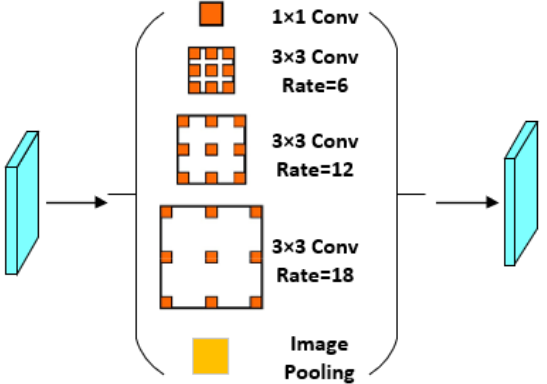
Figure 3. Illustration of Atrous Spatial Pyramid Pooling.